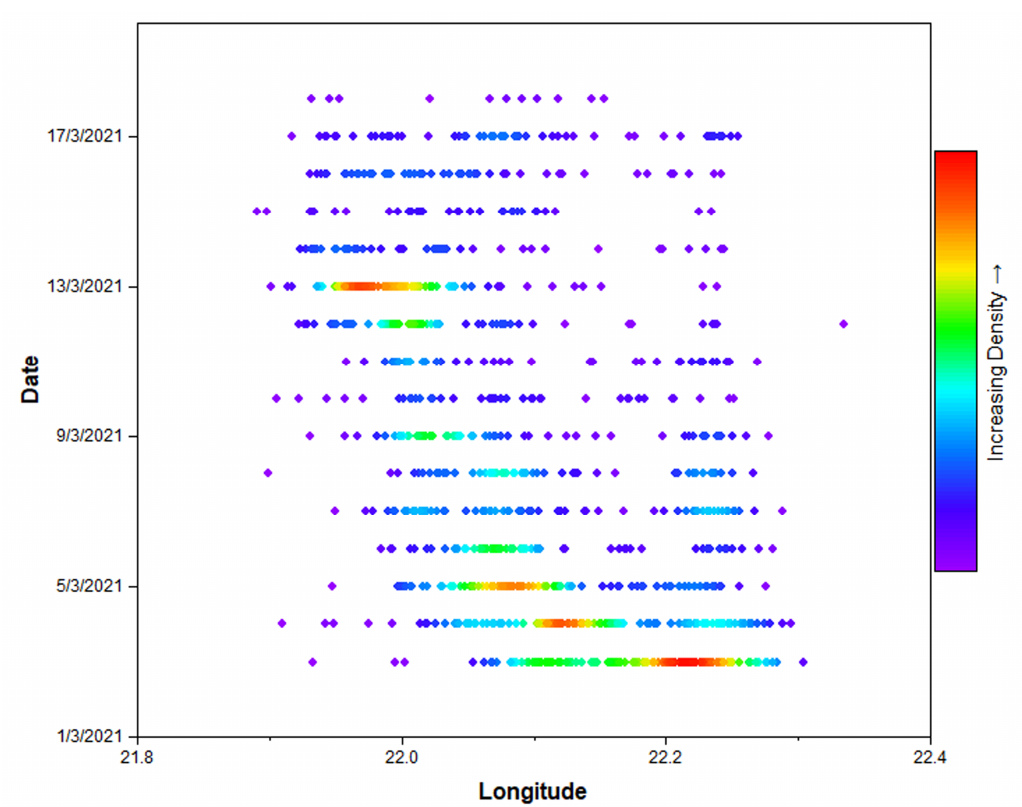
Figure 13. Spatial distribution (longitude) of earthquake density for different dates.